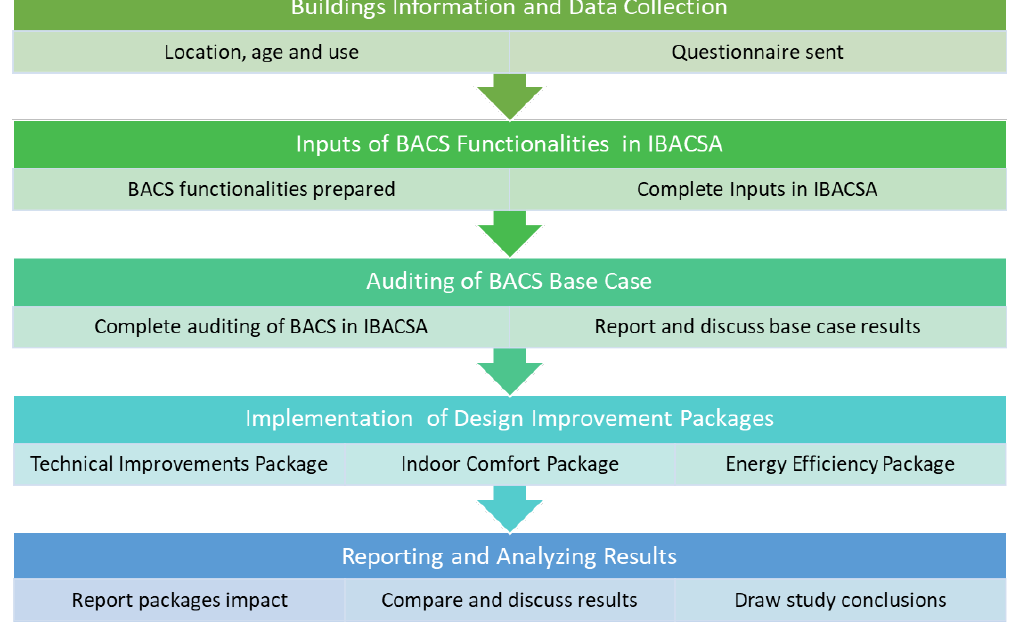
Figure 4. Overall work